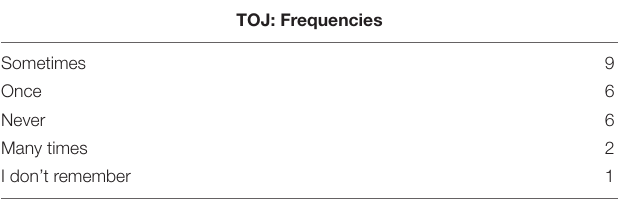
TABLE 1 | Frequencies of coded category “Tears of joy”.